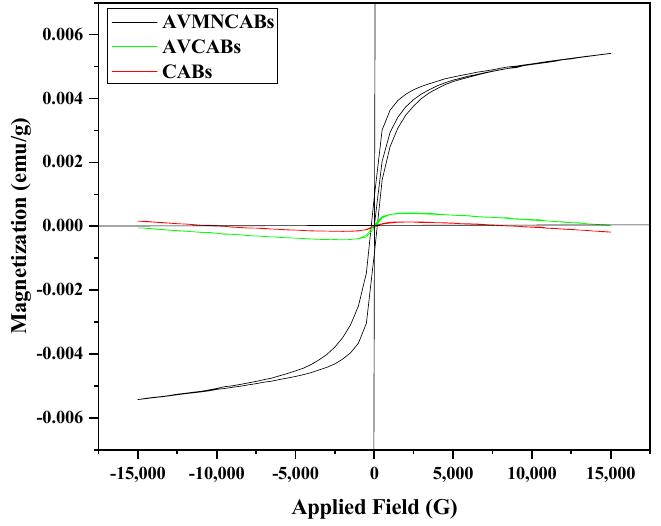
Figure 5. Vibrating sample magnetization (VSM) of CABs, AVCABs, and AVMNCABs (at room temperature).